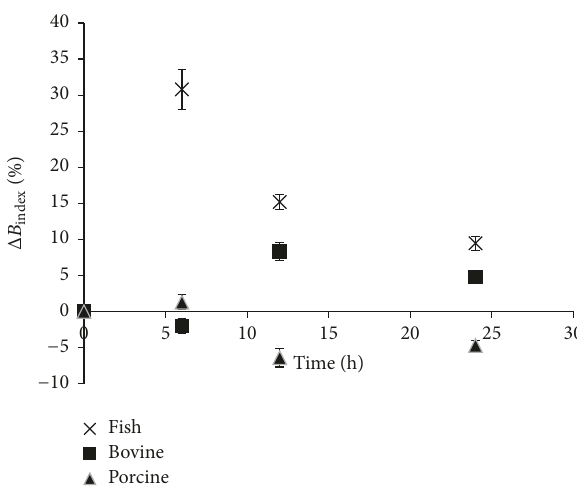
Figure 2: Change in the browning index due of chymotrypsin digestion on xylose-induced nonenzymatic browning of gelatin from different sources. Δ𝐵 : change in browning index